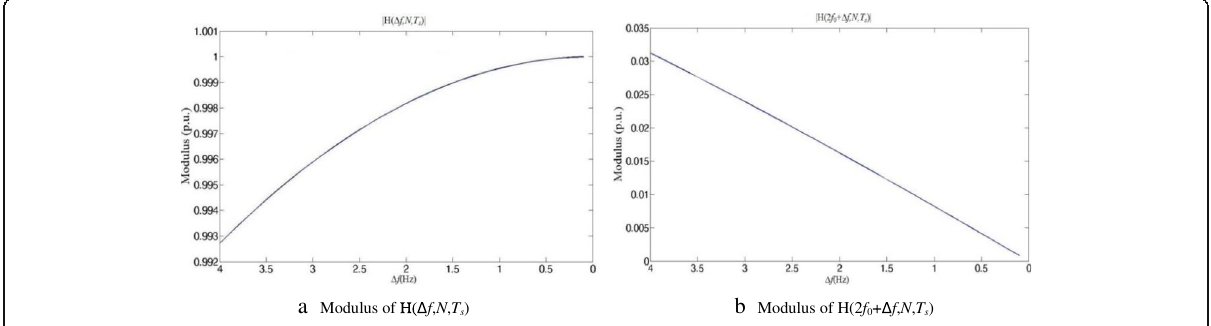
Fig. 18 Moduli of H( Δ f , N , T s ) and H(2 f 0 + Δ f , N , T s ) vs. Δ f when Δ f approaches 0 ( f 0 = 60